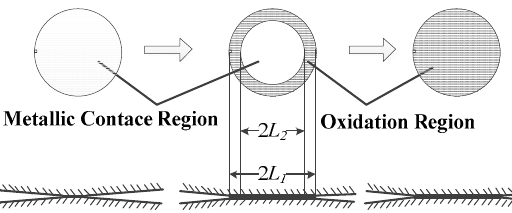
Figure 1. The degradation process of the contact surface.